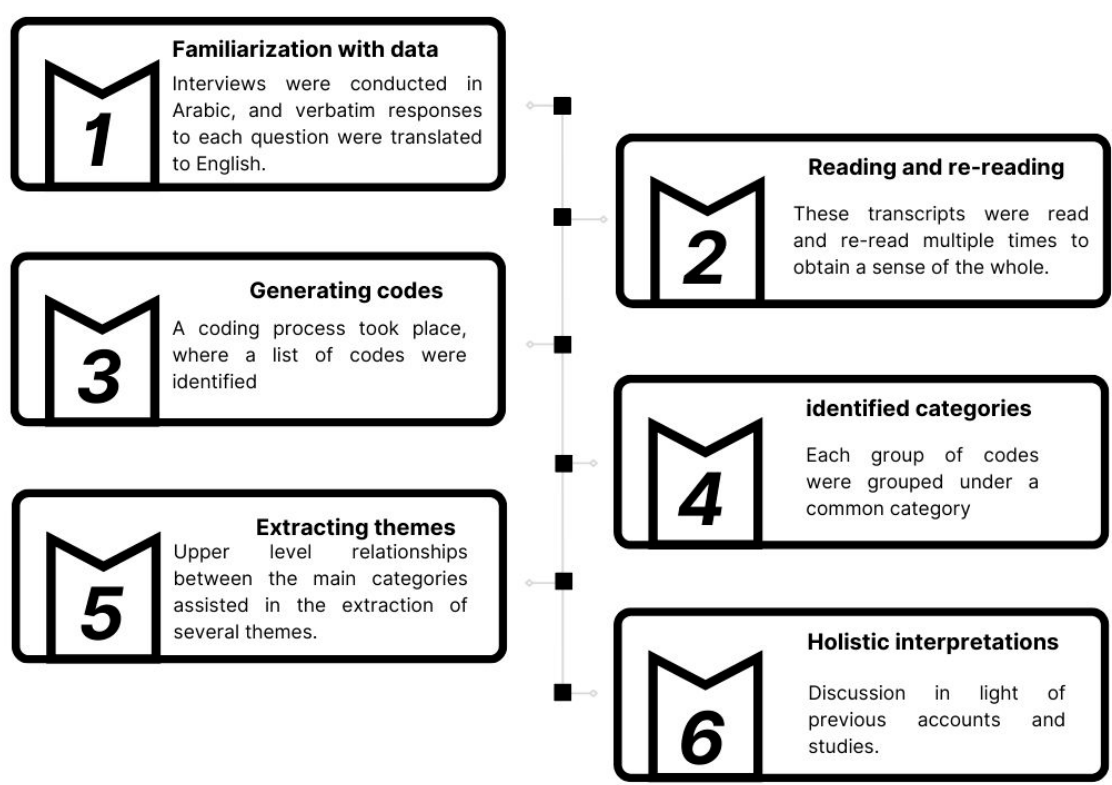
Figure 3. The different stages of the data analysis process. Source(s): Authors (2022).